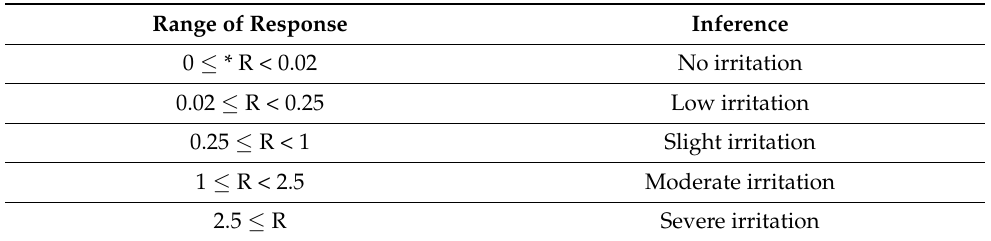
Table 2. Skin irritation